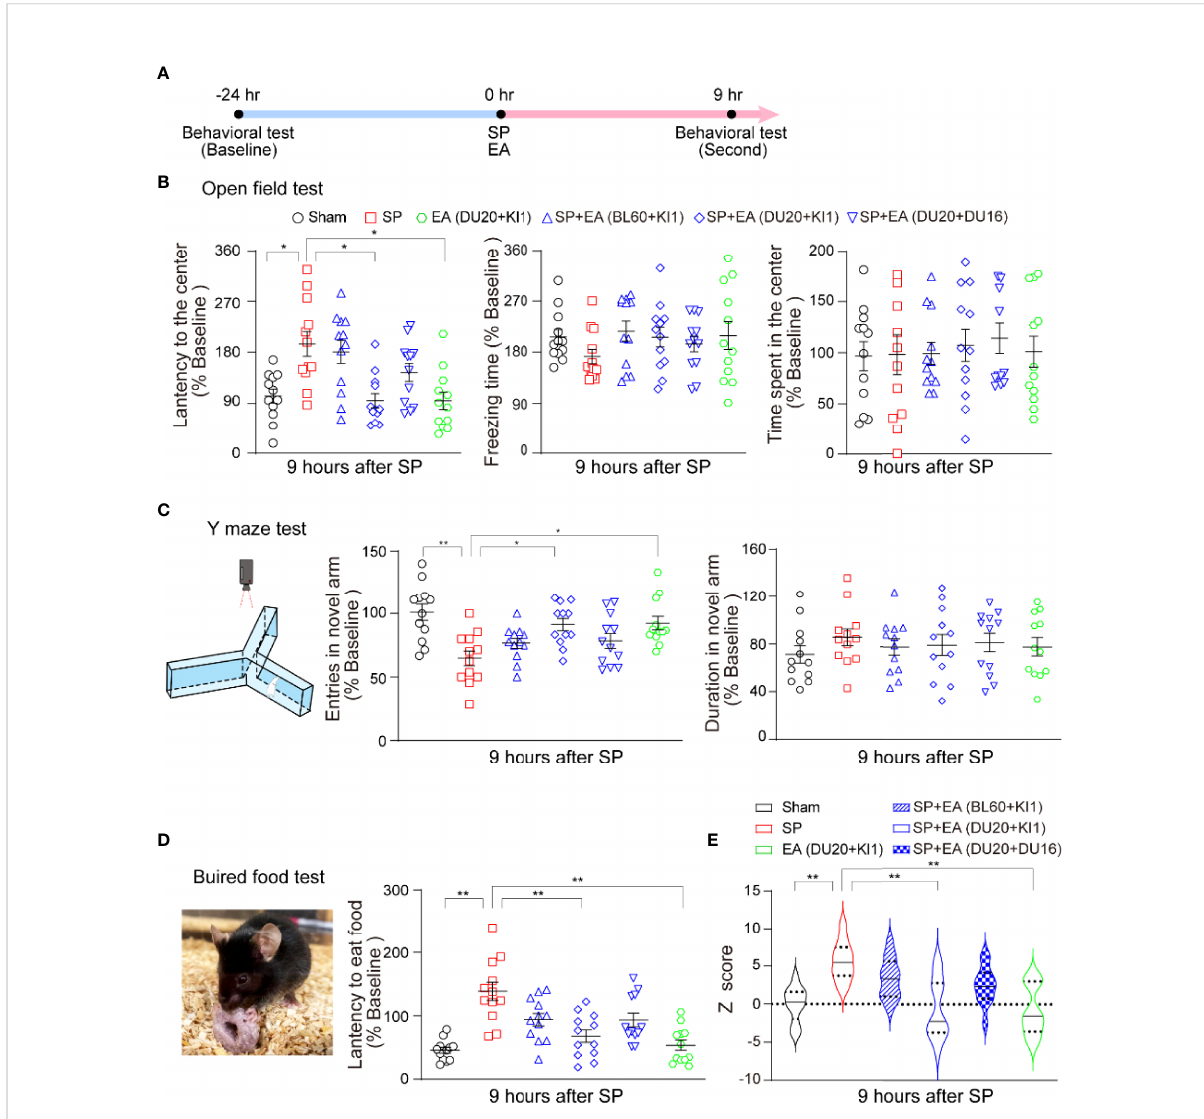
FIGURE 2 EA attenuates the SP-induced delirium-like behavior in mice. (A) Diagram of procedures and behavioral tests. (B) Effects of EA and SP on latency to the center (left panel), freezing time (middle panel), and the time spent in the center (right panel) of the open fi eld test. p -values indicate the difference in these changes between SP vs. sham; SP vs. SP plus EA (DU20+KI1); SP vs. EA (DU20+KI1) ( n = 12, one-way ANOVA followed by Bonferroni post-hoc analyses). (C) The carton of the Y maze test (left panel). The effects of EA and SP on entries in the novel arm (middle panel) and duration in the novel arm (right panel) of Y maze test in mice at 9 h after the surgery. p -values indicate the difference in these changes between SP vs. sham; SP vs. SP plus EA (DU20+KI1); SP vs. EA (DU20+KI1) ( n = 12, one-way ANOVA followed by Bonferroni post-hoc analyses). (D) The picture of the buried food test (left panel). The effects of EA and SP on the latency to eat food in the mice at 9 h after the surgery (right panel). The p -values indicate the difference in the latency between SP vs. sham, SP vs. SP plus EA (DU20+KI1), SP vs. EA (DU20+KI1) ( n = 12, one-way ANOVA followed by Bonferroni post-hoc analyses). (E) The effects of EA and SP on composite Z score in mice at 9 h after the surgery. EA (DU20+KI1) attenuated the SP-induced delirium-like behavior in the mice. p -values indicate the difference in the composite Z score between SP vs. sham; SP vs. SP plus EA (DU20+KI1); SP vs. EA (DU20+KI1) ( n = 12, one-way ANOVA followed by Bonferroni post-hoc analyses). Data are represented as mean ± SEM. * p < 0.05, ** p < 0.01. SP, surgical pain; EA, electroacupuncture; SEM, standard error of mean; BL60, DU20, DU16, KI1: